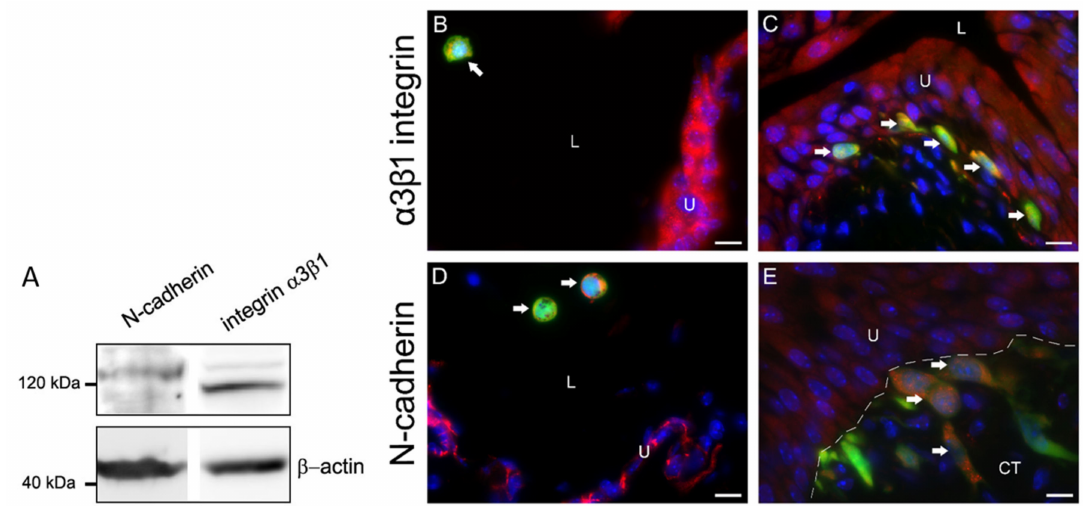
Figure 3. Expression of α 3 β 1 integrin and N-cadherin in MB49-GFP cancer cells with internalized nanoparticles in vitro and in vivo. ( A ) Western blot analysis of MB49 cell culture lysates. The detected bands proved that MB49 cells expressed N- cadherin (120 kDa) and α 3 β 1 integrin (117 kDa). β -actin (45 kDa) was used as a loading control. Molecular weight markers are indicated. ( B , D ) GFP-transduced and α 3 β 1 integrin- or N-cadherin-positive cancer cells (arrows) (orange-colored, due to merged green fluorescence of GFP and red fluorescence of α 3 β 1 integrin or N-cadherin) in floating cancer cells (arrows) in the lumen of the bladder 1 hour after intravesical application. ( C , E ) GFP-transduced and α 3 β 1 integrin- or N-cadherin-positive cancer cells (arrows) (orange-colored, due to merged green fluorescence of GFP and red fluorescence of α 3 β 1 integrin or N-cadherin) under the basal lamina 72 h after intravesical application. Note dark spots of no fluorescence inside cancer cells, representing internalized nanoparticles in endosomes (in ( B , D )). Nuclei were stained with DAPI (blue fluorescence). The dashed line represents the basal lamina. U—urothelium; L—lumen of the urinary bladder; CT—connective tissue. Bars are 10 µ